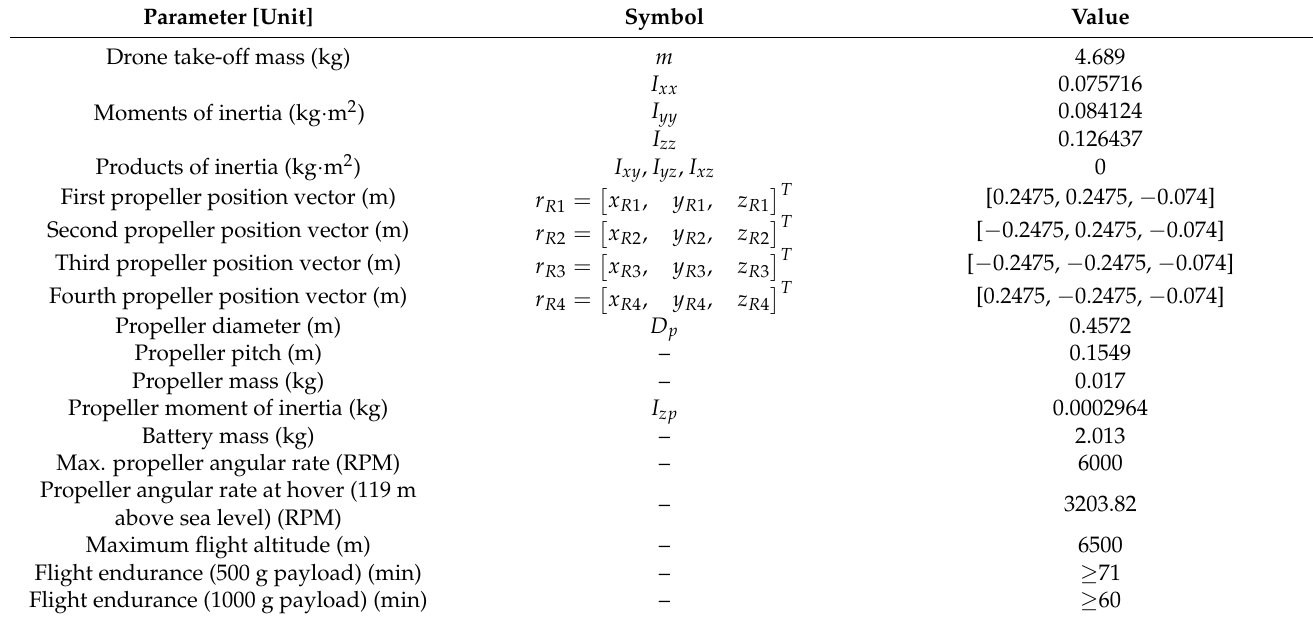
Figure 2. Moments of inertia measurements using trifilar pendulum ( a ) I xx ( b ) I yy ( c ) I zz . The resulting parameters are presented in Table 1. Table 1. Quadrotor